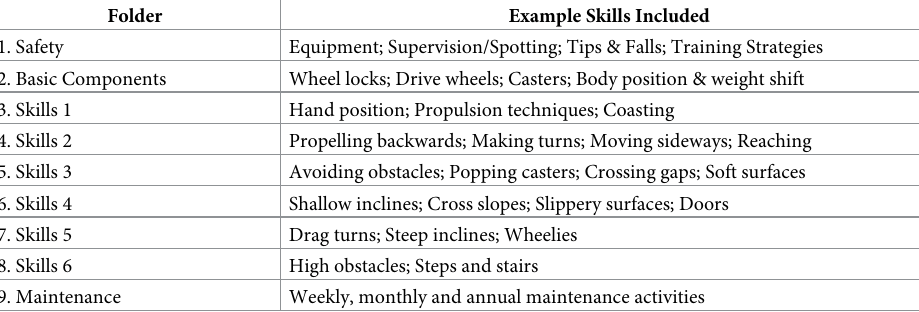
Table 1. Examples of skills included in home training